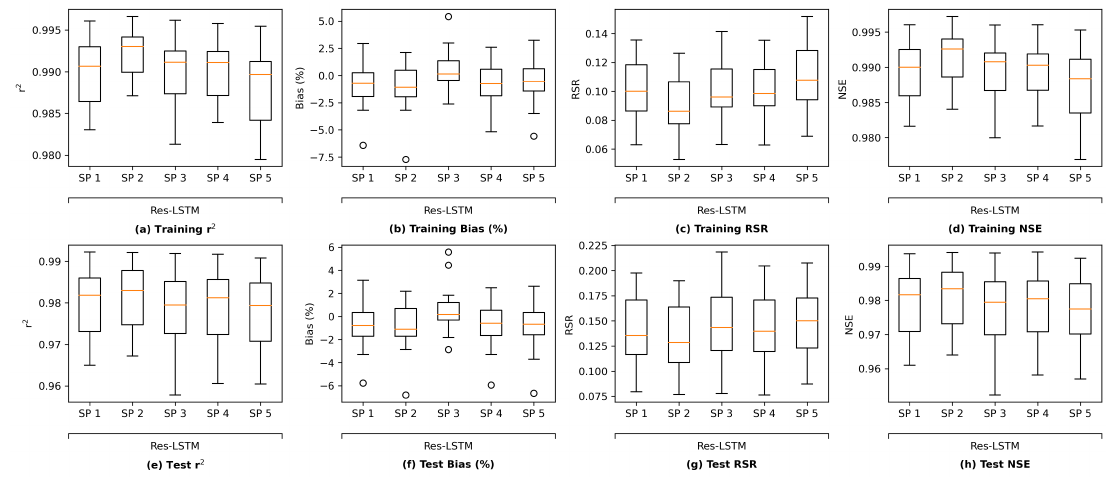
Figure A7. Comparison of the 5-fold cross-validation on the Res-LSTM architecture using observed data. “SP” stands for